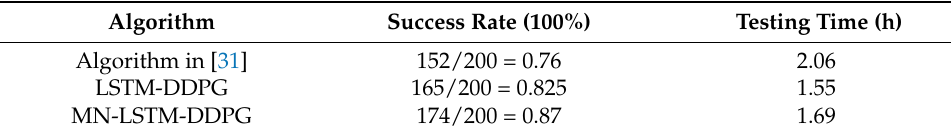
Table 5. Comparison of test results of the improved algorithm in simulation Figure 6b.